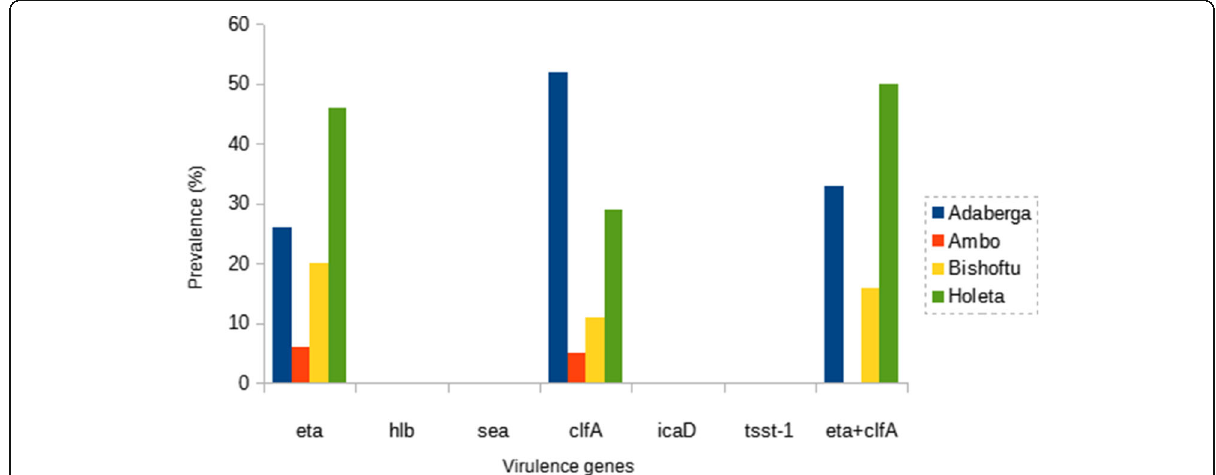
Fig. 3 Prevalence of virulence genes in S. aureus isolated from bovine subclinical